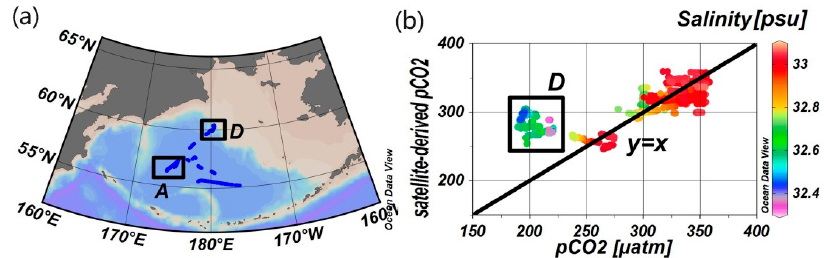
Figure 6. The comparison between eight-day composite satellite-derived p CO 2 and underway data. ( a ) Location of the match-up data; ( b ) scattering plot between satellite-derived p CO 2 and underway data. Box D is highlighted for the derivation in the slope.